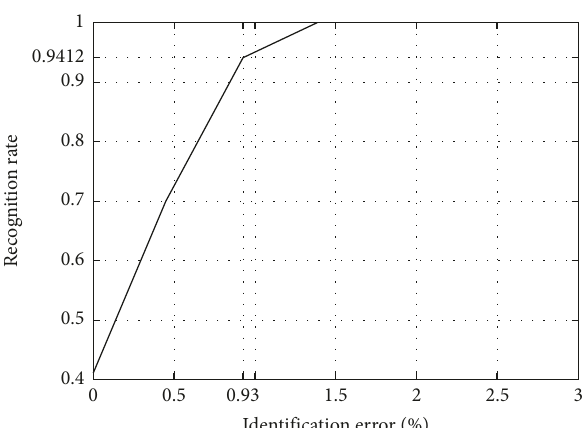
Figure 14: Recognition rate of MFL defect feature.